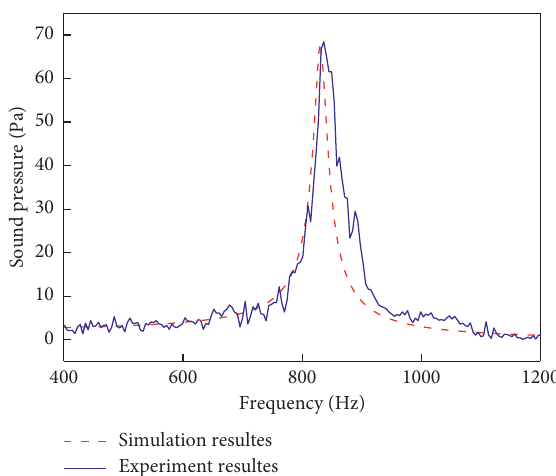
Figure 18: Comparisons of experiment results and simulation results of Helmholtz resonator.